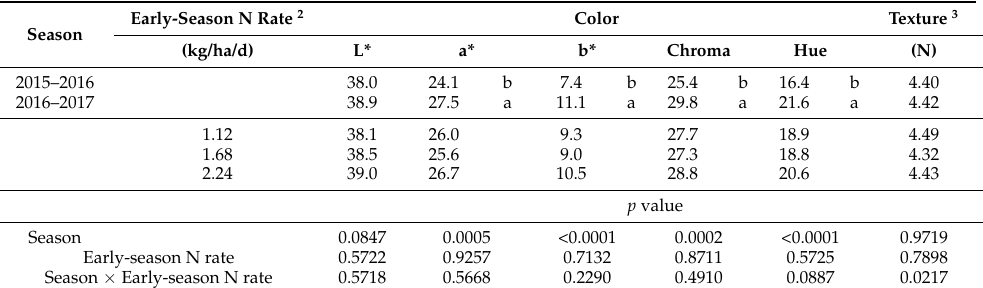
Table 3. Color of ‘Florida Radiance’ strawberry as affected by season and early-season nitrogen (N) fertilization rate 1 .